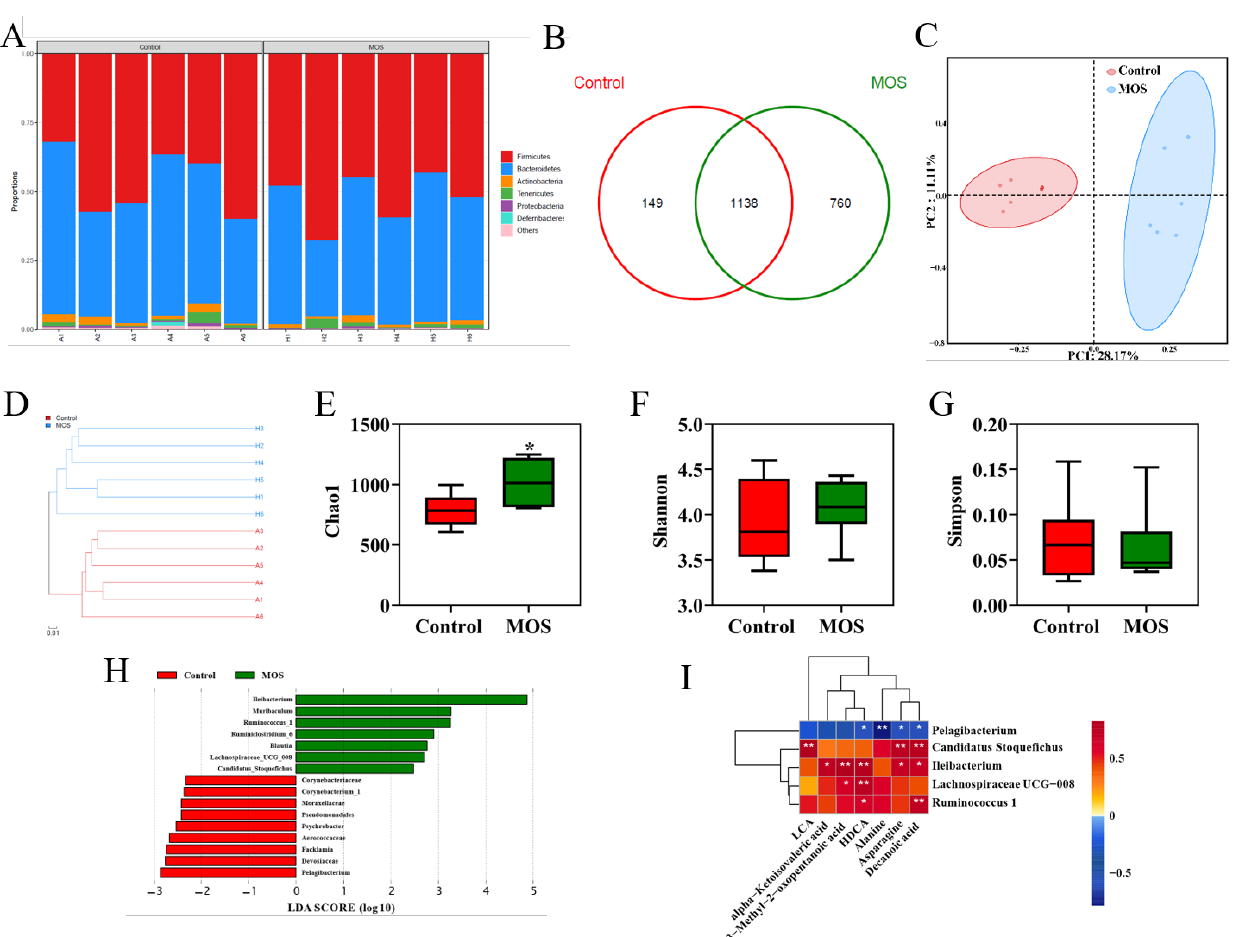
Figure 3. Gut microbiome of mice fed mannan oligosaccharides. ( A ) Relative abundance analysis at the phylum level. ( B ) OTU Venn analysis. ( C ) Principal coordinate analysis (PCOA). ( D ) Hierarchical clustering analysis. ( E ) Chao1 value. ( F , G ) Shannon and Simpson index of gut microbiota. ( H ) LDA score of gut microbiota. ( I ) Correlations between serum differential metabolites and differential gut microbiota. * p < 0.05 versus the control